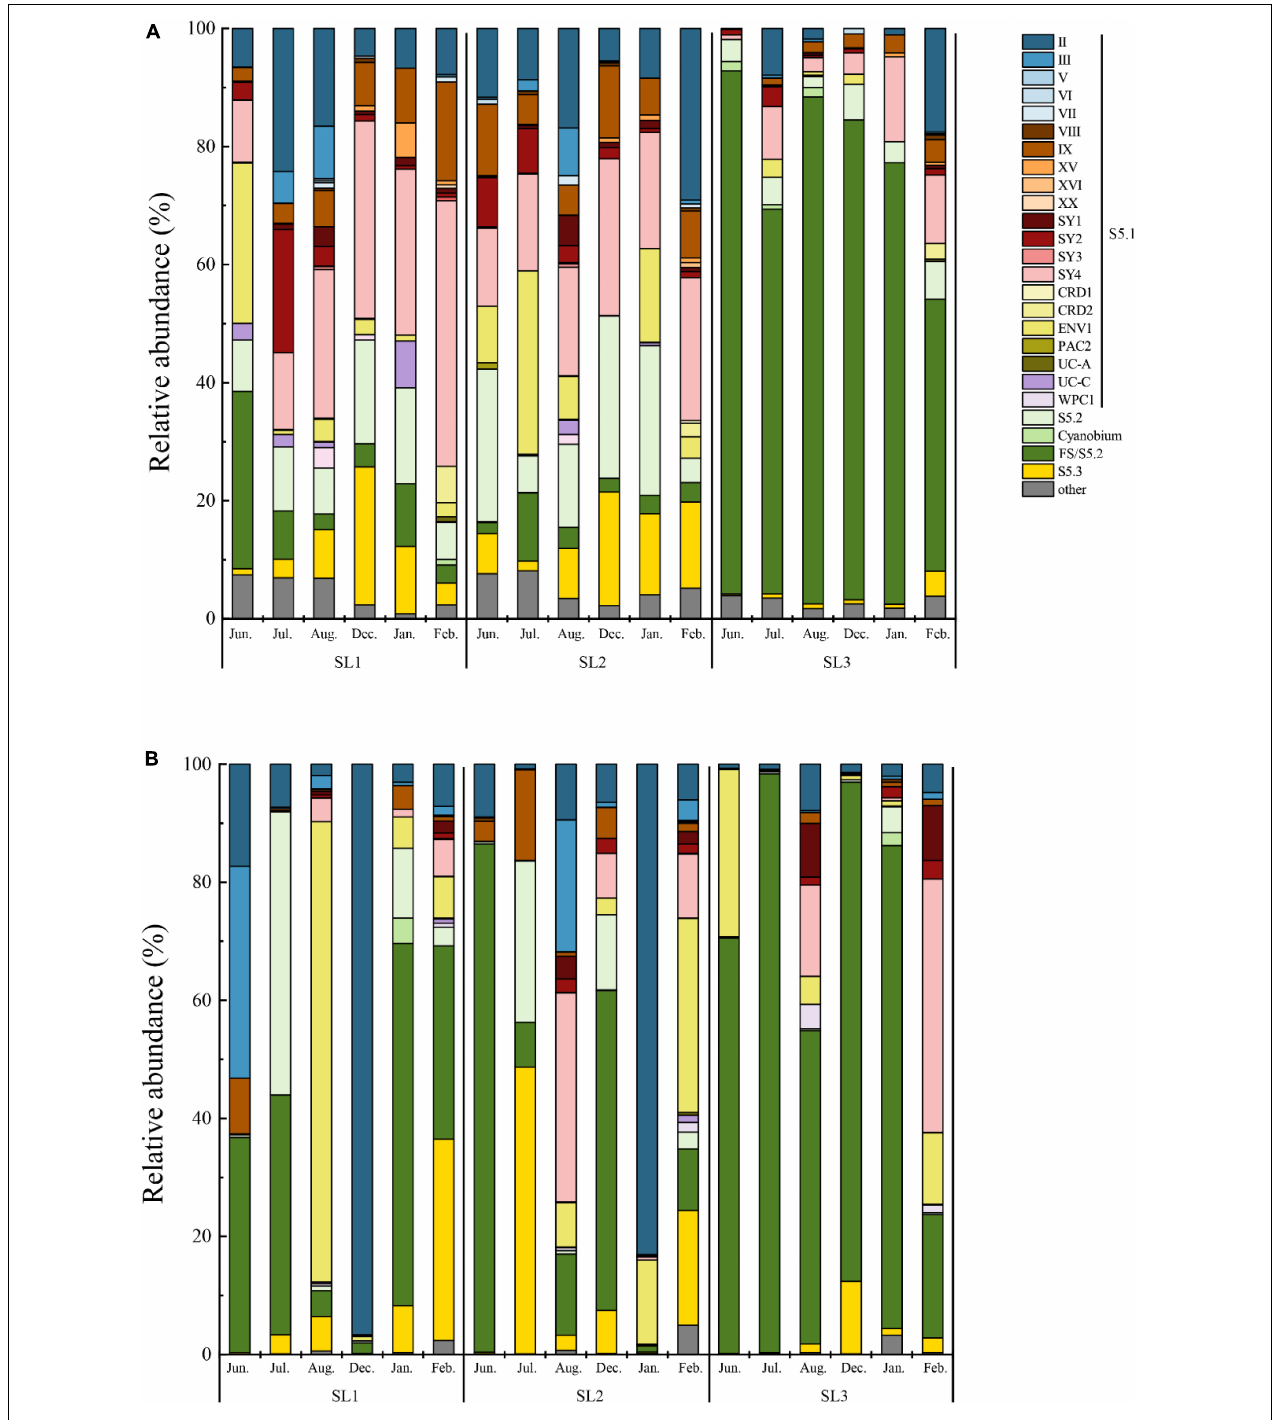
FIGURE 3 | Community structure of Synechococcus assemblages at DNA (A) and cDNA (B) levels.